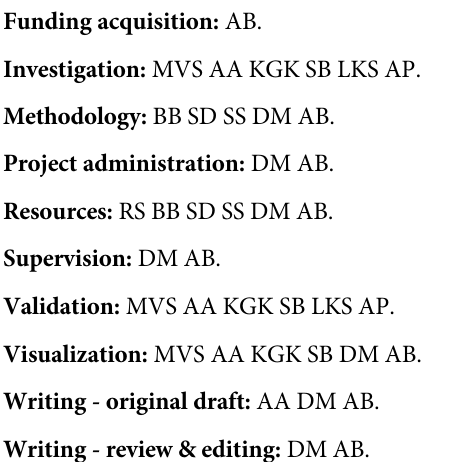
S2 Table. Fetal outcomes of intra amniotic injections with GBS MVs.